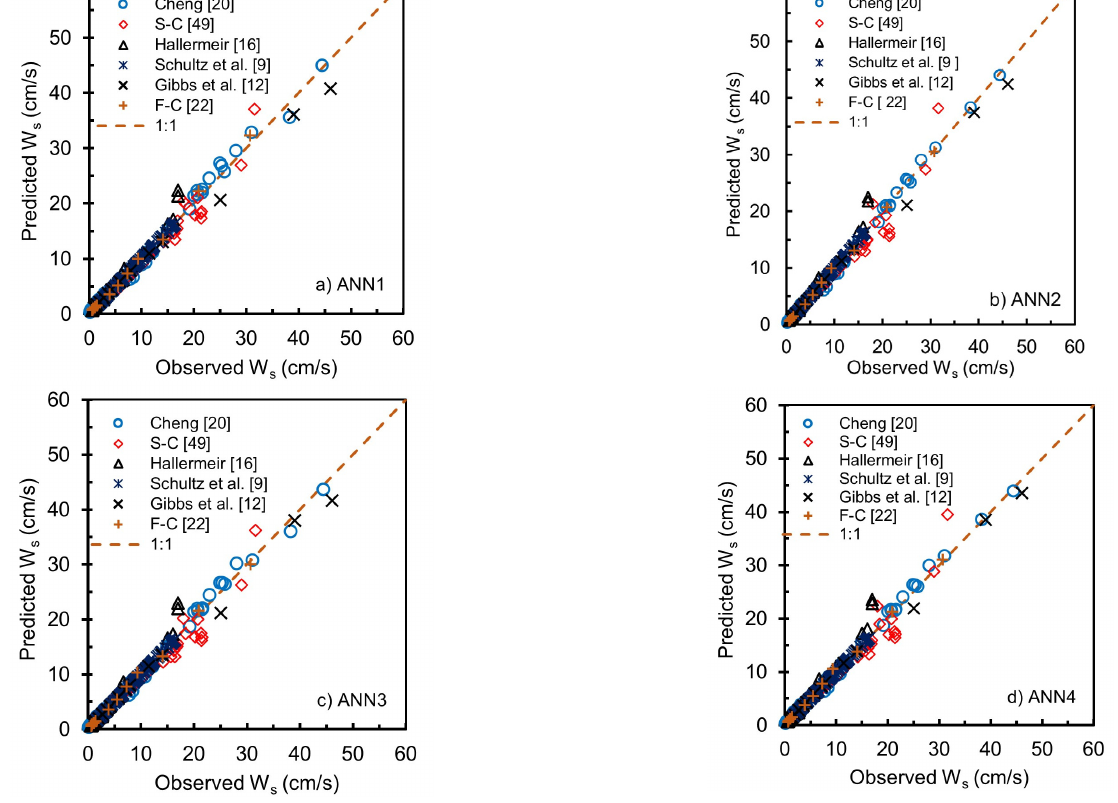
Figure 8. Scattering plot for results of testing 2 for equations of ANN1 ( a ); ANN2 ( b ); ANN3 ( c ) and ANN4 ( d ).